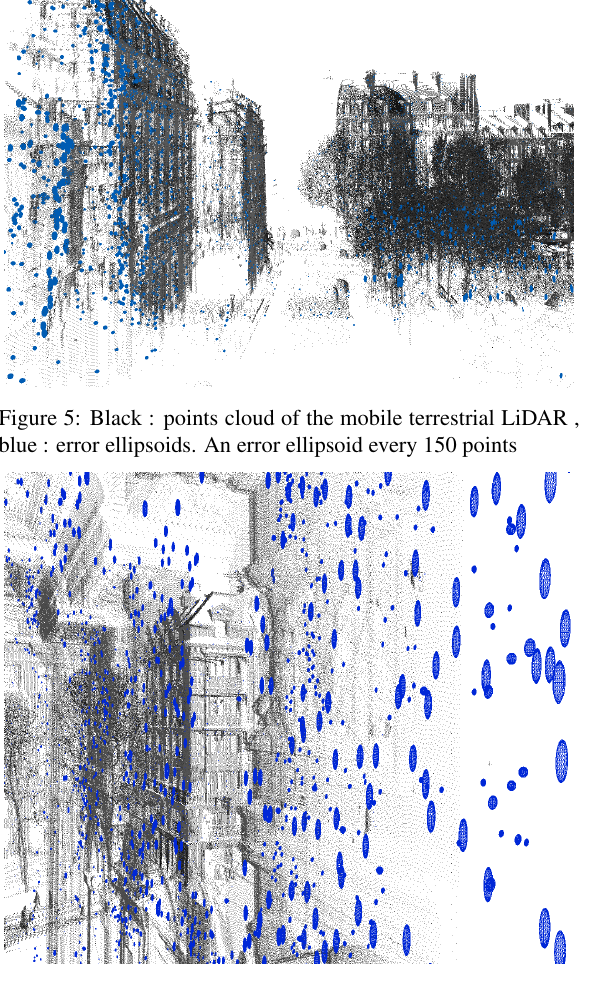
Figure 6: Black : points cloud of the mobile terrestrial LiDAR , blue : error ellipsoids. An error ellipsoid every 100